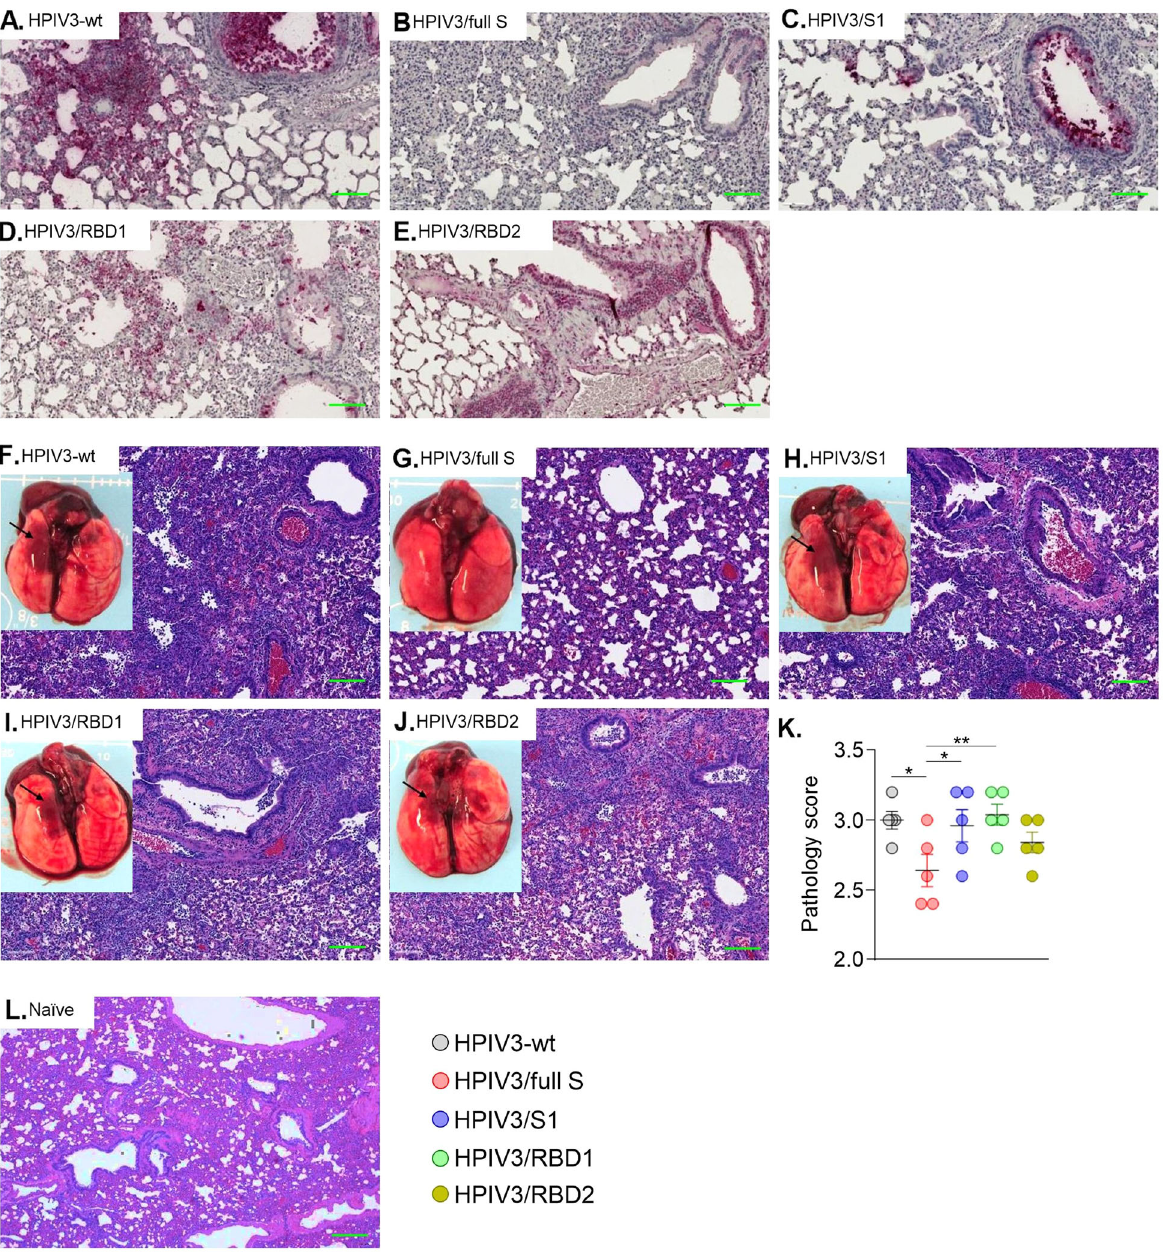
Fig. 6 Virus-induced lung pathology in vaccinated hamsters on day 3 after infection. Immunohistochemical staining of SARS-CoV-2 nucleoprotein (N) antigen in lung tissues ( A – E ) and representative gross and histological lung images ( F – J ). Black arrows show congestion and focal consolidation in the lungs of SARS-CoV-2 infected hamsters. Magni fi cation: ×4. K comparative pathology scores calculated based on criteria described in Supplementary Table 3. Data represent mean ± SEM of n = 5 per group. * p < 0.05; ** p < 0.01 (one-way ANOVA with multiple comparisons, Fisher ’ s LSD test). L histological lung image of naïve hamster taken from our previous study 83 for comparison. Scale bar: 0.25